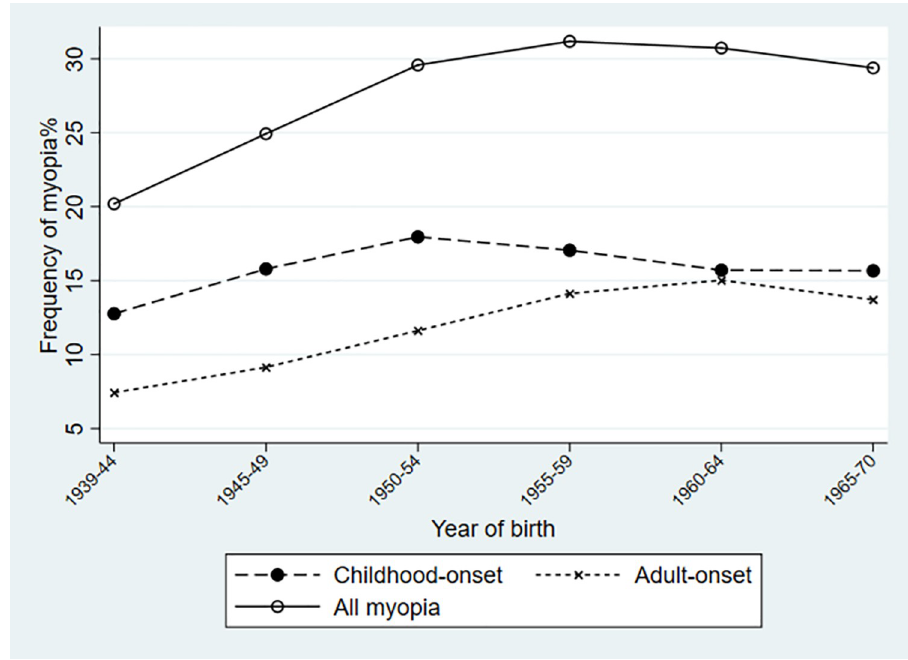
Fig 1. Frequency of myopia (all, childhood-onset and adult-onset). By year of birth as 5-year bands.